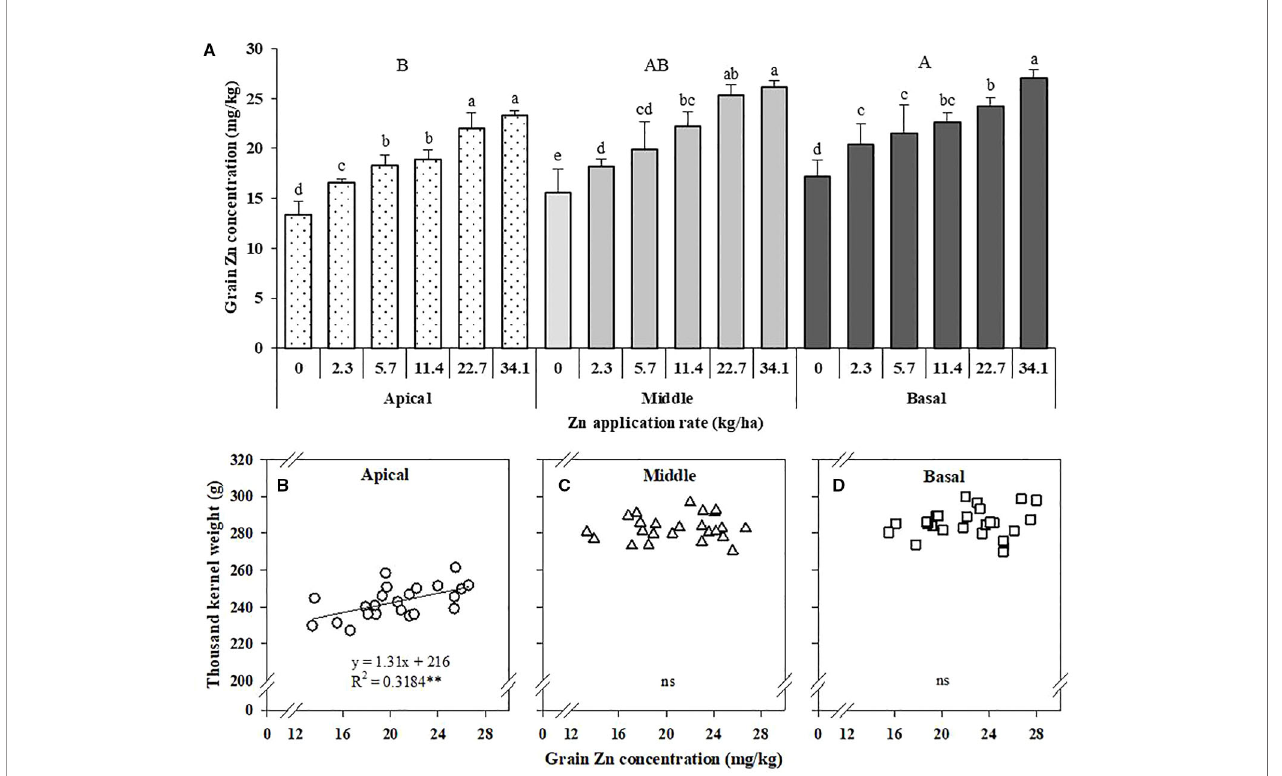
FIGURE 5 | Effects of Zn application on Zn concentration in different sections of maize spikes (A) and correlation of the 1,000-kernel weight of the apical (B) , middle (C) , and basal (D) sections of maize spikes with Zn concentration. Values are the average ± SE of four replicates. Within each section means with the same lowercase letters are not signi fi cantly different at P < 0.05 according to Fisher ’ s LSD test. The different capital letters indicate a signi fi cant difference between sections. ** P < 0.01. ns, not signi fi